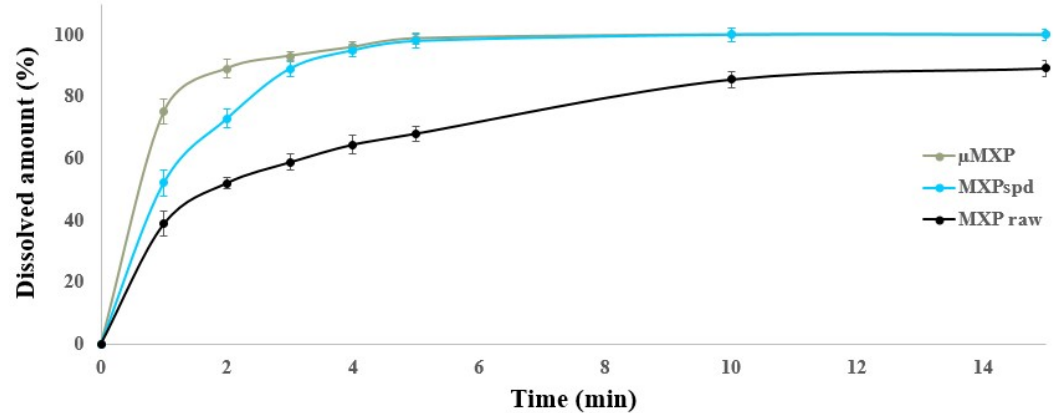
Figure 5. Dissolution test results of the raw MXP, µMXP, and MXPspd.